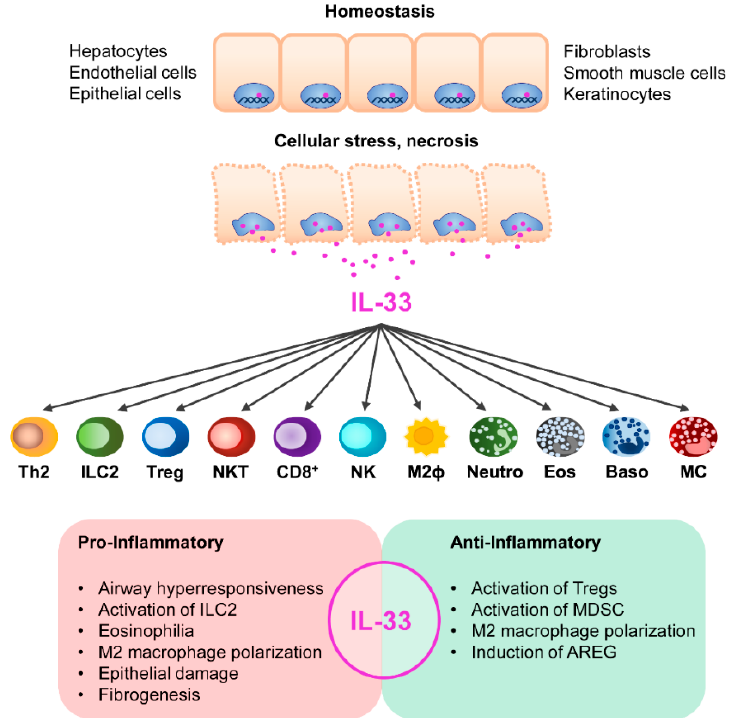
Figure 2. Immune regulatory function of IL-33 in inflammatory diseases. In homeostasis, IL-33 is located in the nucleus where it is associated with chromatin. IL-33 is released from necrotic cells and activates a variety of lymphoid and myeloid immune cells expressing the IL-33 receptor ST2. Dependent on the disease, IL-33 exerts very different functions. On the one hand, IL-33 can drive inflammation while on the other hand it also supports immunosuppression. ILC2: type 2 innate lymphoid cell, Treg: regulatory T cell, NKT: natural killer T cell, NK: natural killer cell, M2 ϕ : M2 macrophage, Neutro: neutrophil, Eos: eosinophils, Baso: basophil. MC: mast cell, MDSC: myeloid-derived suppressor cell, AREG: amphiregulin.